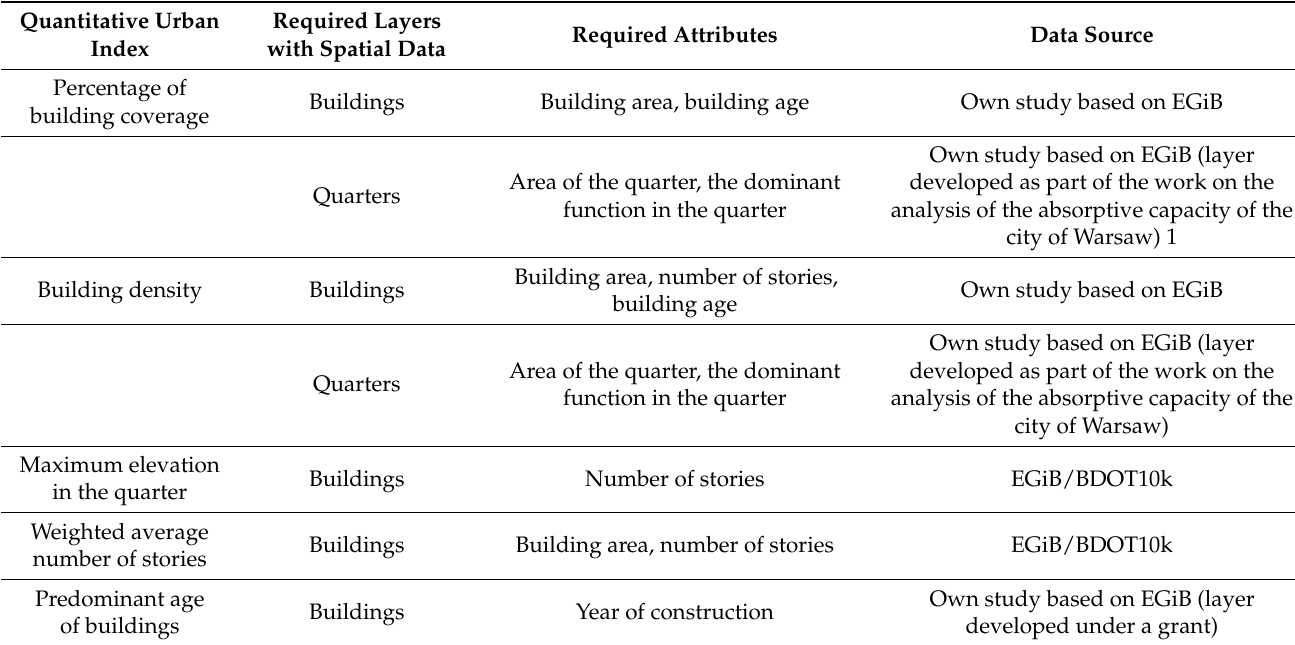
Table 1. Selected urban indicators for analysis. Source: own